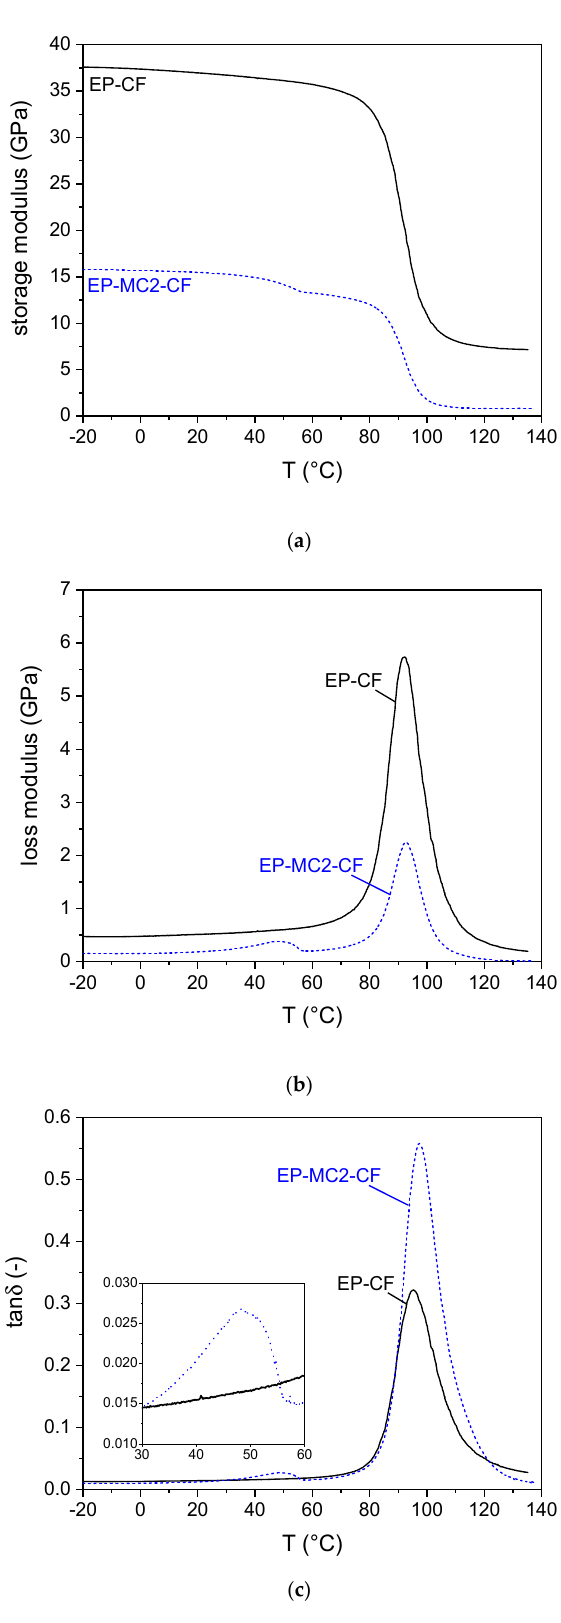
Figure 12. DMA thermograms of the prepared laminates. ( a ) Storage modulus E’, ( b ) loss modulus E”, ( c ) tan δ .